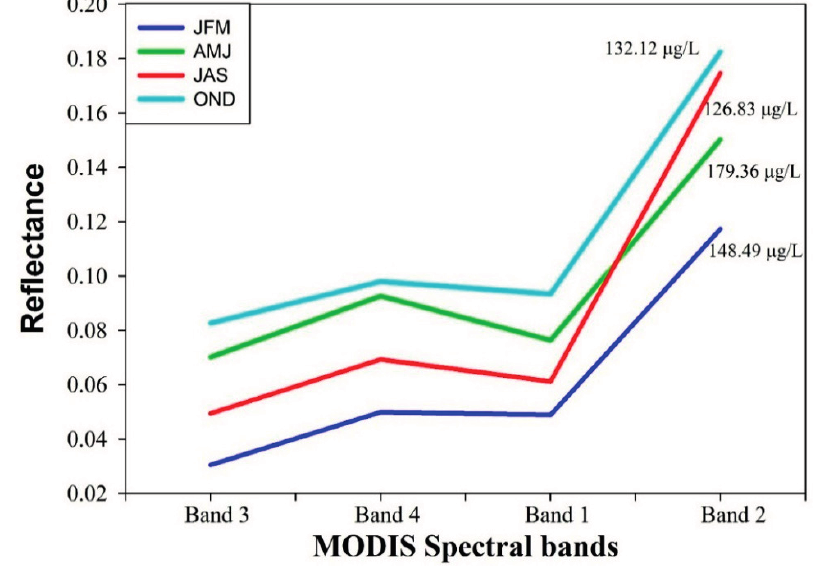
Figure 5. Average reflectance spectra of MOD09GA for each seasonal period.